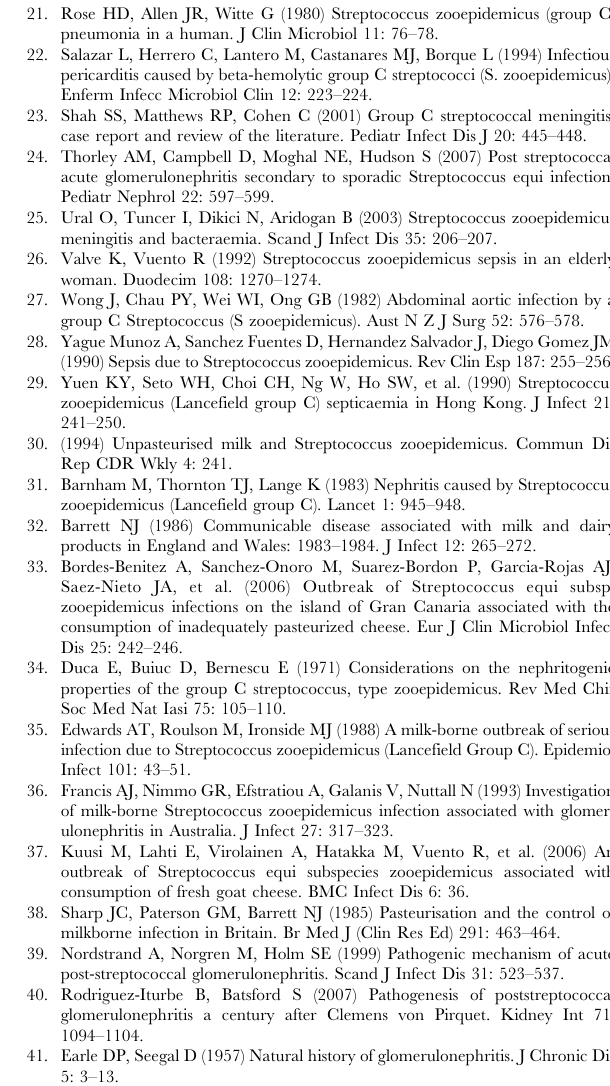
Table S3 Products with Predicted Double-Glycine Secretion Signal Sequence. Inferred proteins with bacteriocin/competenece peptide-like double-glycine secretion signal sequence